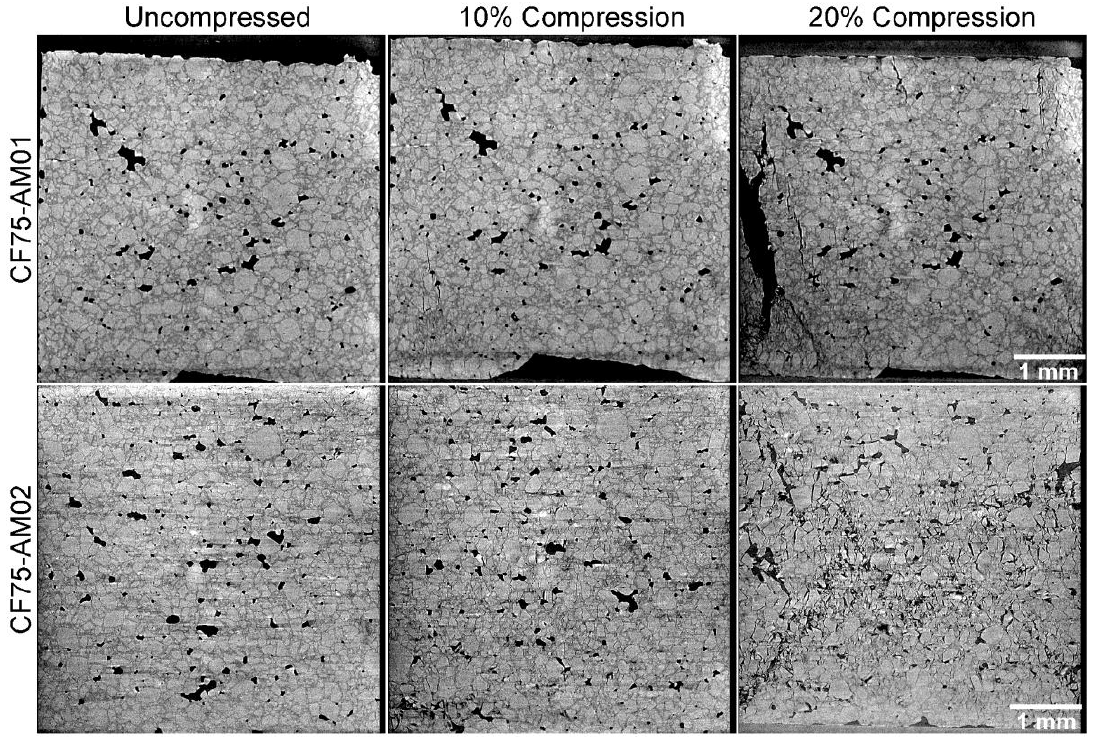
Figure 6. Comparison of CF75-AMO1 and CF75-AMO2 at increasing compressions. Both samples show extensive cracking by 20% compression, with CF75-AMO2 exhibiting the most damage.